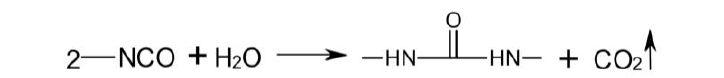
Figure 4. Scheme of isocyanate reaction with water.